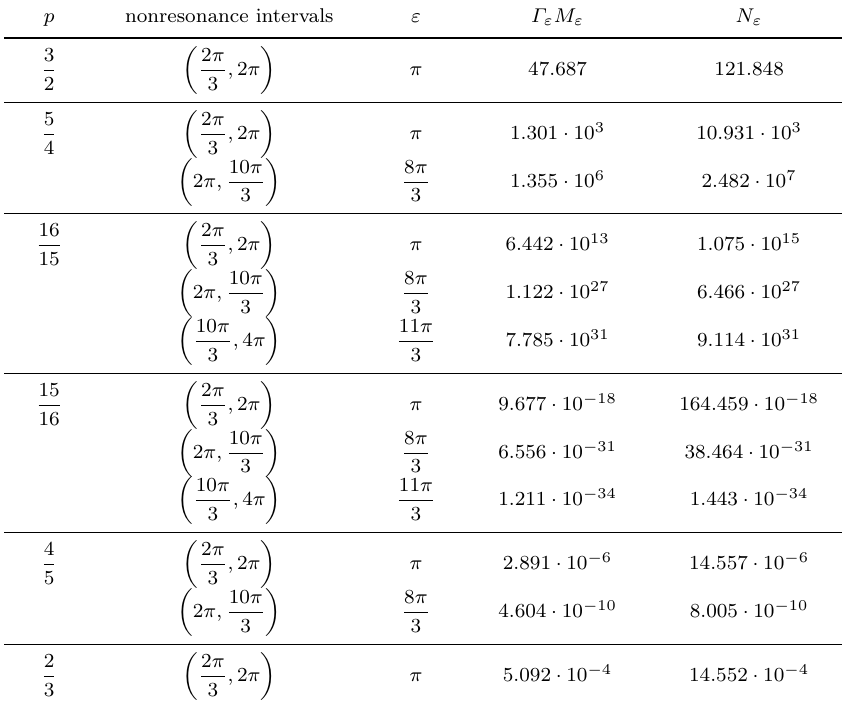
Table 2. Results of calculations for the resonant BVP (5.11), (5.12). p nonresonance